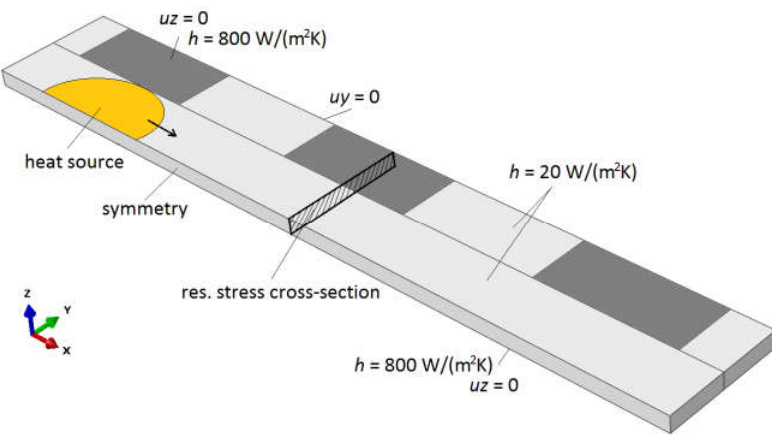
Figure 4. Model geometry and applied boundary conditions for the thermal and mechanical analyses. The three dark grey areas indicate the boundary conditions emulating the clamping of the plate, whereas the yellow half-circle indicates the area where the moving heat source (Equation (3)) is applied.